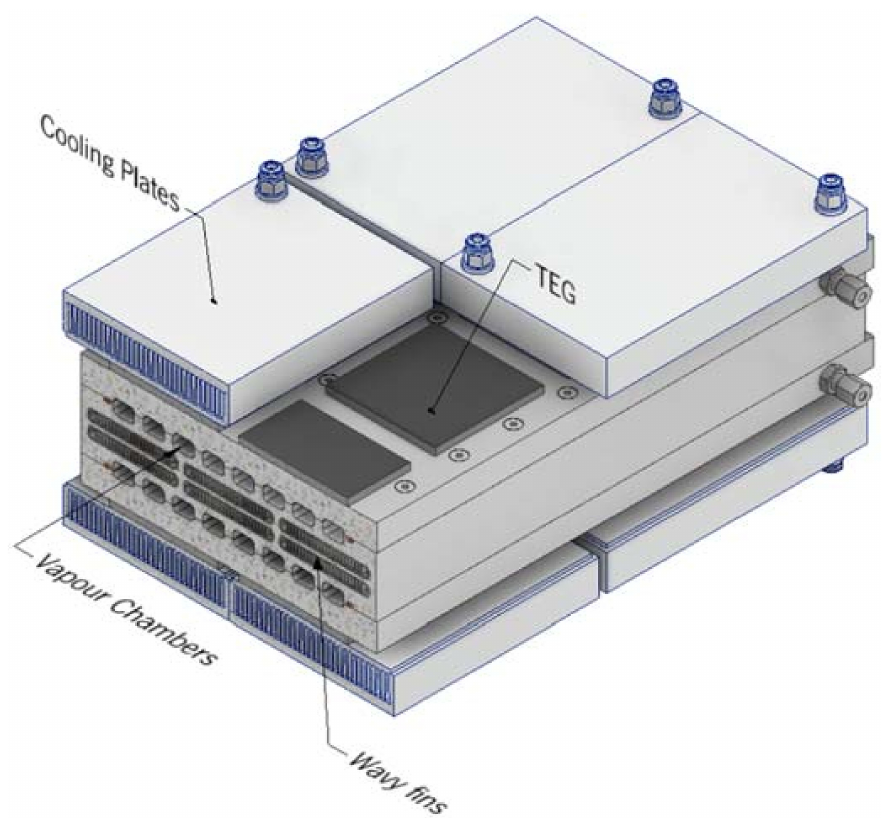
Figure 14. Exhaust TEG generator concept evolution based on vapor chambers instead of HPs and wavy fins instead of corrugated pipes.